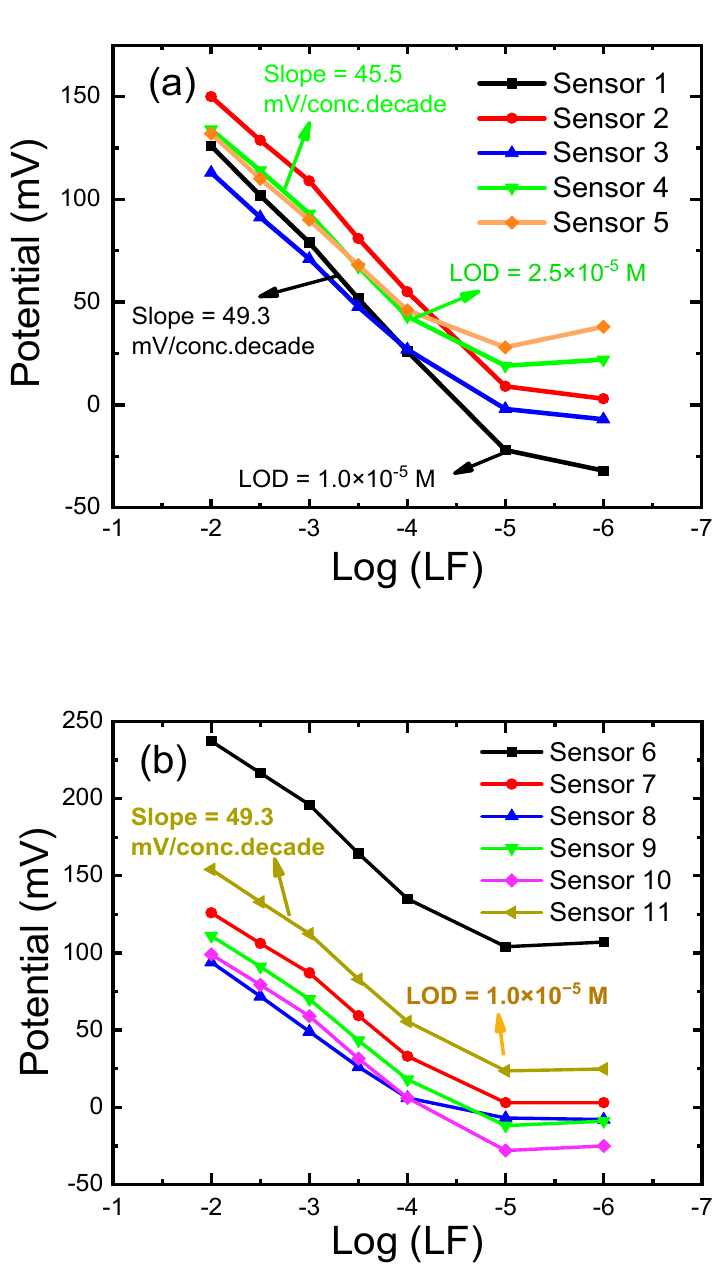
Figure 4. Response characteristics of the prepared electrodes for LF determination: ( a ) calibration curve of PVC membrane electrodes (PVCEs, sensors 1–5) prepared by varying the ratio of PVC powder, ion-pair (LF-TPB), plasticizers (TCP or DOP); ion exchanger (St-TFPMB), modifier (CD), and solvent (THF); ( b ) calibration curve of carbon paste electrodes (CPEs, sensors 6–11) formulated from different carbon sources (Gr, rGO, and MWCNTs), plasticizers (TCP or DOP); ion exchanger (St-TFPMB), and lipophilic ion pair (LF-TPB). The electrode compositions (%, wt / wt ) are given in (Table 1). All measurements were at pH 4.1 using acetate buffer at room temperature of 22 ± 2 °C .